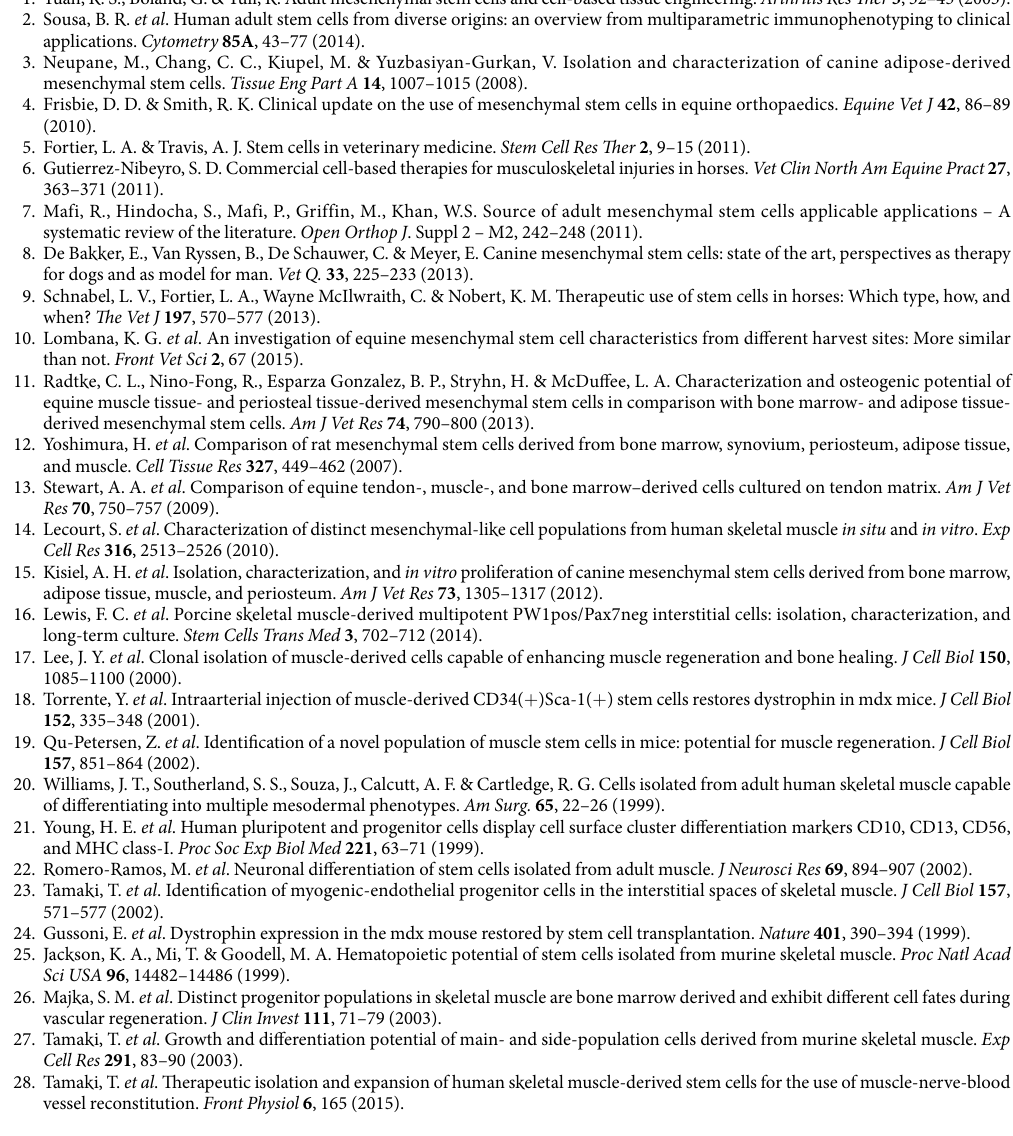
oclonal antibodies (Table 1): CD105, CD44, MCH II, CD45, CD90 (equine and human cells), CD73, CD19 and CD34 (human cells only). After washing with MACSQuant Running Buffer, the cells were fixed with 4% for- maldehyde solution. Data were acquired using MACSQuant Analyzer and evaluated using FCS Express 4 Flow Cytometry Software (De Novo Software, Los Angeles, CA, USA). Immunomodulatory capacities. The cells obtained from human or equine muscles were plated at 4000 cells/ cm 2 in a flat-bottomed 24-well plate. After a short period of adherence, allogeneic LT purified from peripheral blood and stimulated by phyto-hemagglutinin (PHA/IL2) were incubated with the plated stem cells for 5 days of co-culture in RPMI-1640 medium supplemented with 10% FBS. We tested several stem cell:LT ratios (from 1:80 to 1:4) to investigate their importance in the stem cell mediated effects. Lymphocyte proliferation was evaluated after carboxyfluorescein diacetate_succinimidyl ester (CFDA-SE) labeling. For CFDA-SE labeling (CellTraceTM CFSE cell proliferation kit), 10 mM CFDA-SE dye was used to stain 10 7 LT before co-incubation with stem cells. After 5 days of co-culture CFSE fluorescence was analyzed by flow cytometry. The CFSE profile of the labeled cells was composed of several distinctive peaks representing the number of cell divisions that the proliferated lymphocytes had undergone after activation. LT proliferation was expressed by the percentage of positive